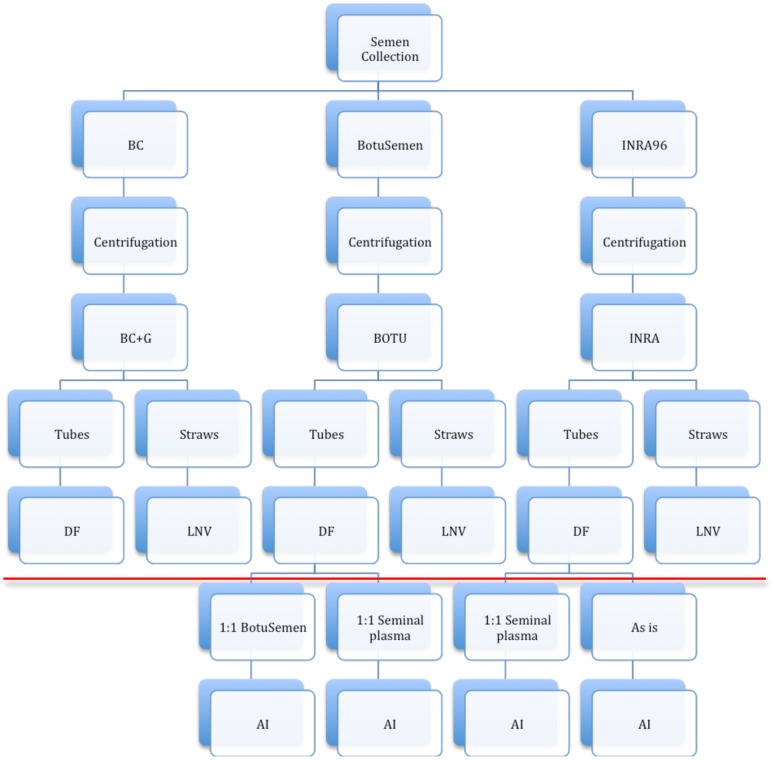
Experimental design flow chart.The study consisted of two stages (experiments). The first stage aimed to assess three freezing extenders (BC+G, BOTU, INRA) and two freezing techniques—directional freezing (DF) and freezing in the vapour phase over liquid nitrogen (LNV). At the second stage, samples frozen with the selected extenders (BOTU and INRA) and freezing technique (DF) were used for AI. After thawing, the BOTU samples were either diluted 1:1 in autologous seminal plasma or in BotuSemen. The INRA samples were either diluted 1:1 in autologous seminal plasma or used as is. A horizontal line on the figure indicates the decision-making point between the two experimental stages.